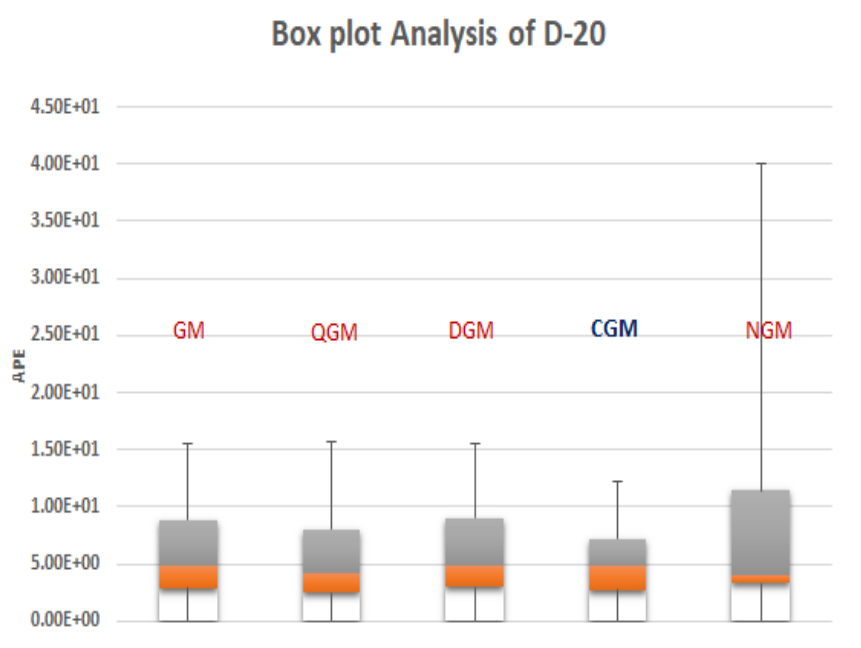
Figure 6. Boxplot analysis for D-20.